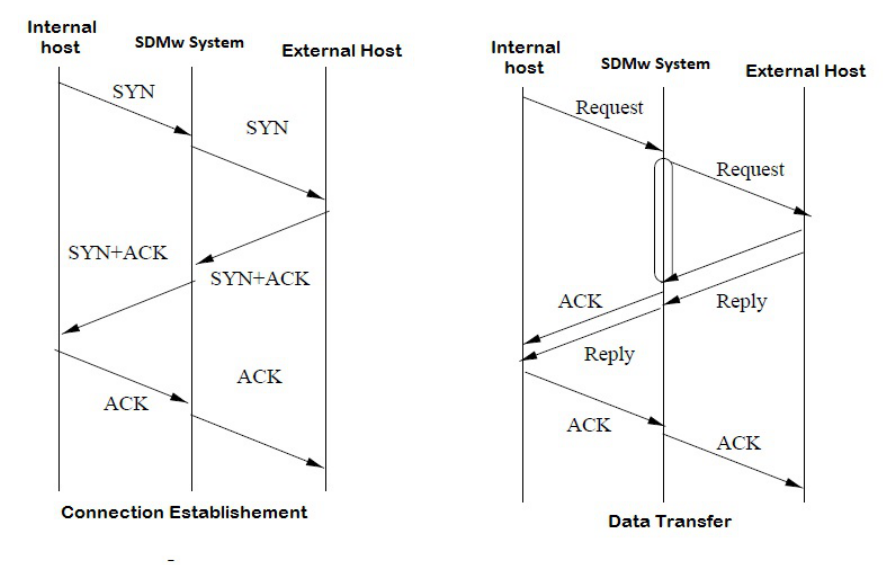
Figure 2. Transmission Control Protocol connection